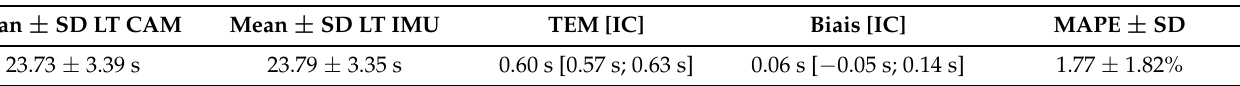
Table 6. Statistical agreement between lap times computed by IMU and gold standard video (n = 952 laps) respectively.